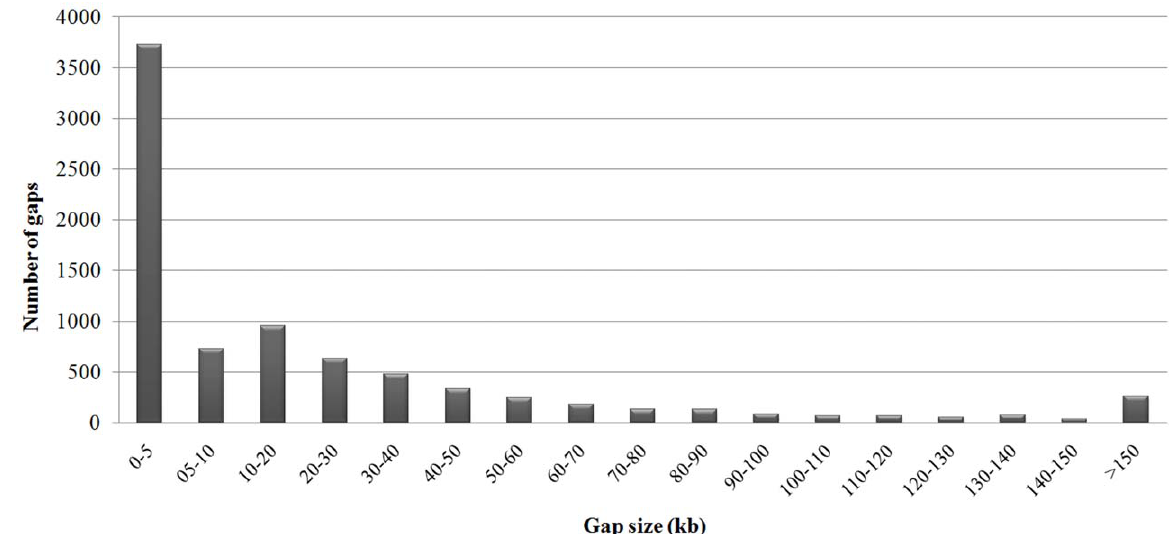
Figure 3. Frequency distribution of size of gaps between SNPs included on the IPSC peach 9 K SNP array v1. Gap sizes were based on SNP physical locations in the Peach v1.0 assembly.